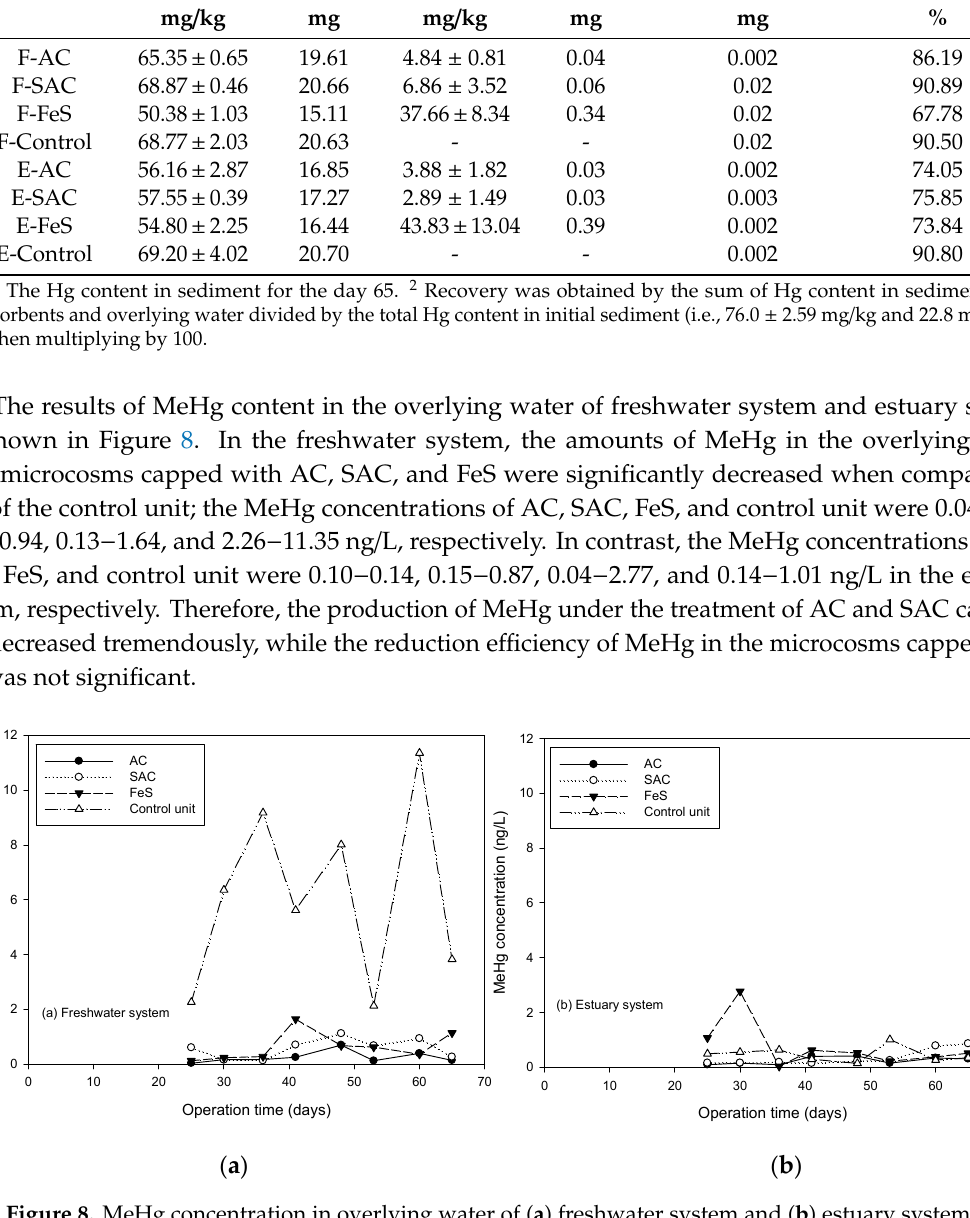
Figure 8. MeHg concentration in overlying water of ( a ) freshwater system and ( b ) estuary system.